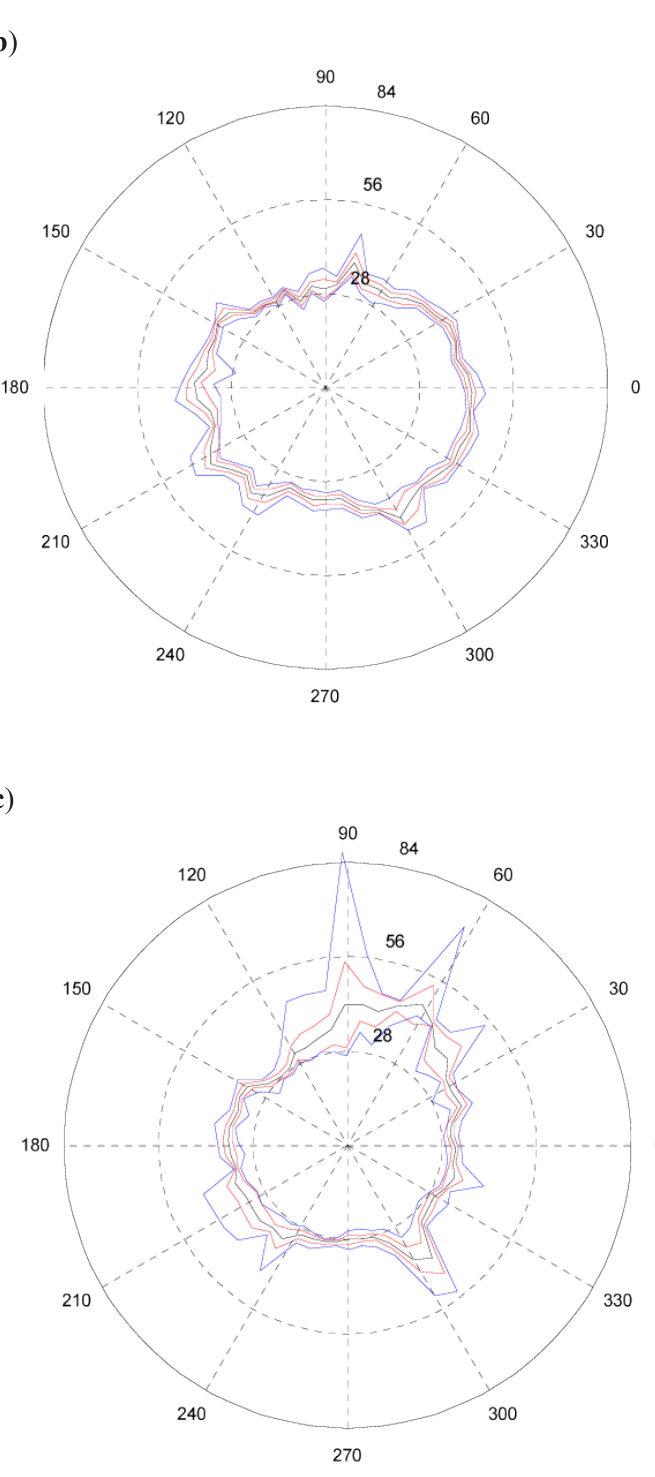
Figure 4. Polar plots of intra- and inter-meridian ACA means and 95% confidence regions on these means for each of the three subjects. In each part of this figure the black polar profile rep- resents the mean ACA for each of the different meridians while the red profiles are used to indicate the upper and lower limits for the 95% confidence regions on these means. The blue polar profiles indicate maxima and minima for all meridians. a) Sub- ject 1, b) Subject 2 and c) Subject